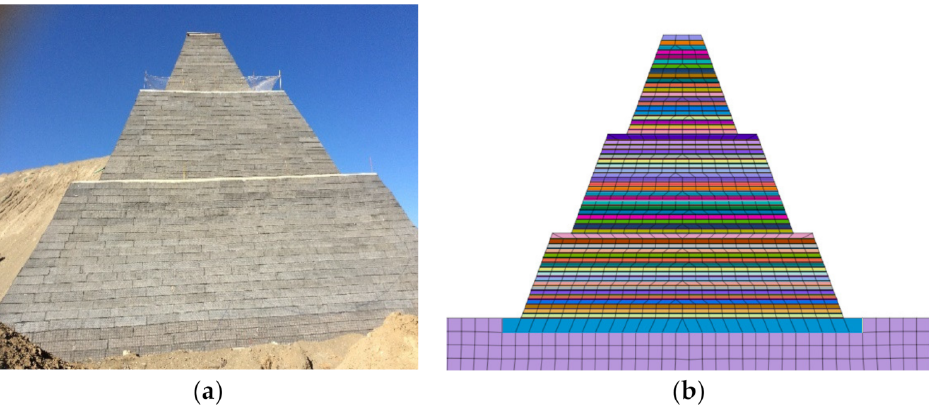
Figure 6. ( a ) Third-grade soil embankment; ( b ) numerical model.